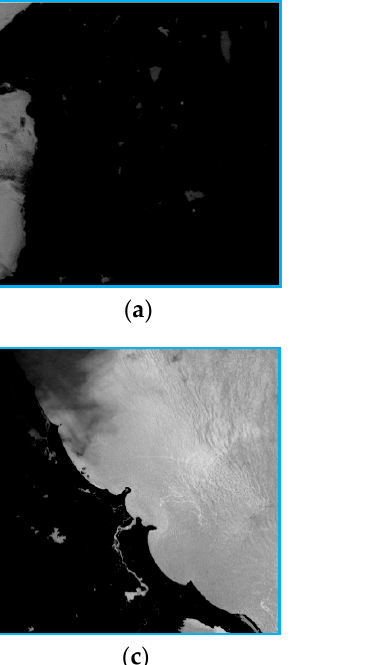
Figure 14. Kapa curve of β .